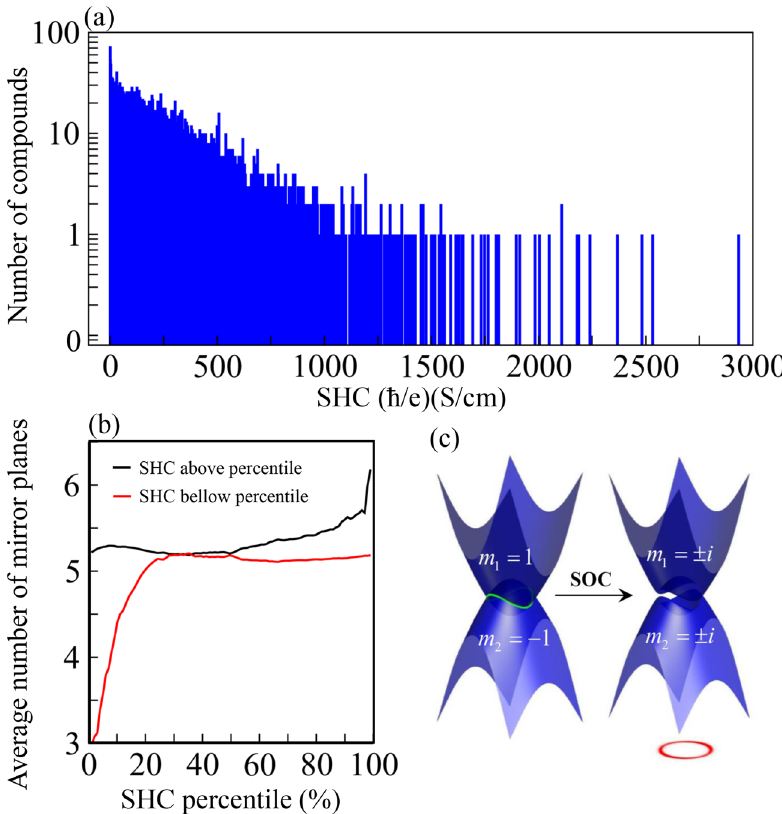
Fig. 2 Calculated intrinsic SHC. a Histogram of SHC values for all calculated materials. b Average number of mirror planes for materials with an SHC above a percentile of mirror planes and below a percentile of mirror planes as a function of the percentile. For example, the red curve shows the average number of mirror planes for 80% of the materials with the lowest SHC, whereas the black curve shows the average for the top 20% of the materials. c Illustration of the nodal line mechanism. The splitting of the bands from SOC results in a large SBC along the original nodal line, as illustrated by the red